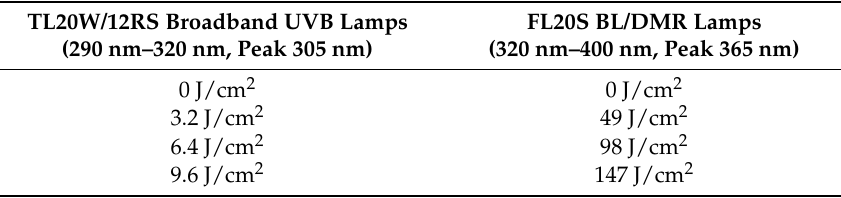
Table 1. Irradiation energy of Dermaray Table1. Irradiation energy of Dermaray 200.